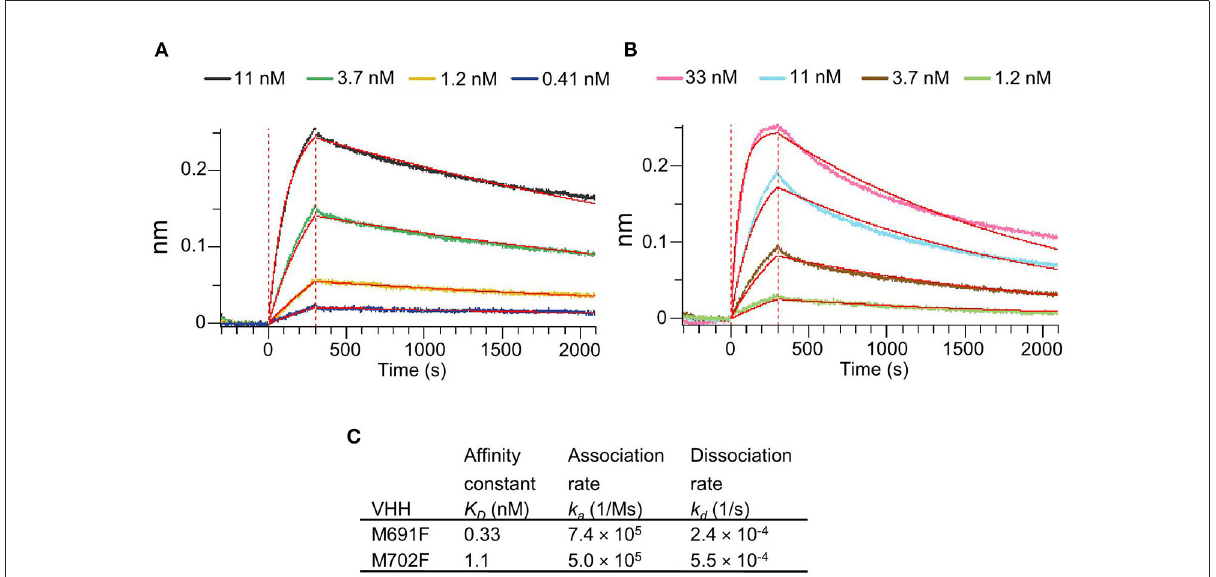
FIGURE2 Affinity binding curves and deduced affinity constants of VHHs. Using Biolayer Interferometry on an Octet Red96 system, association and dissociation rates were determined by tight multivalent capturing of FMDV A/TUR on optical streptavidin sensors that were loaded with biotinylated M678F VHH. The FMDV-bound sensors were incubated with specific concentrations of M691F (A) or M702F (B) to allow association at time = 0s. After 300s the sensors were then moved to VHH-free solution and allowed to dissociate over a time interval. Curve fitting using a 1:1 interaction model (red lines) allows for the affinity constant ( K D ) to be measured for each VHH (C) .